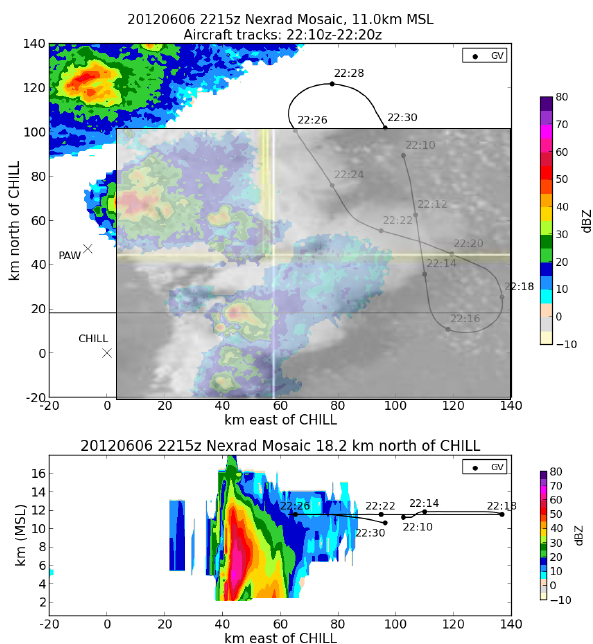
Fig. 3. Track of the G-V during upper anvil sampling of the anvils from the north and south storm on 6 June 2013 together with the 22:15 NEXRAD composite radar. The lower panel depicts a radar cross section through the southern storm at the location of the line near 20km north of CHILL in the top figure. A portion of the 22:15:12 GOES-13 visible satellite image is overlaid on the radar image (the yellow lines on the image depict the Colorado– Nebraska–Wyoming state boundaries). The projection of the flight track on the radar cross section is provided in the lower figure (as de- picted in the upper figure, the flight track encountered cloud but not significant radar returns). The location of the Pawnee and CHILL radar sites is included for reference.